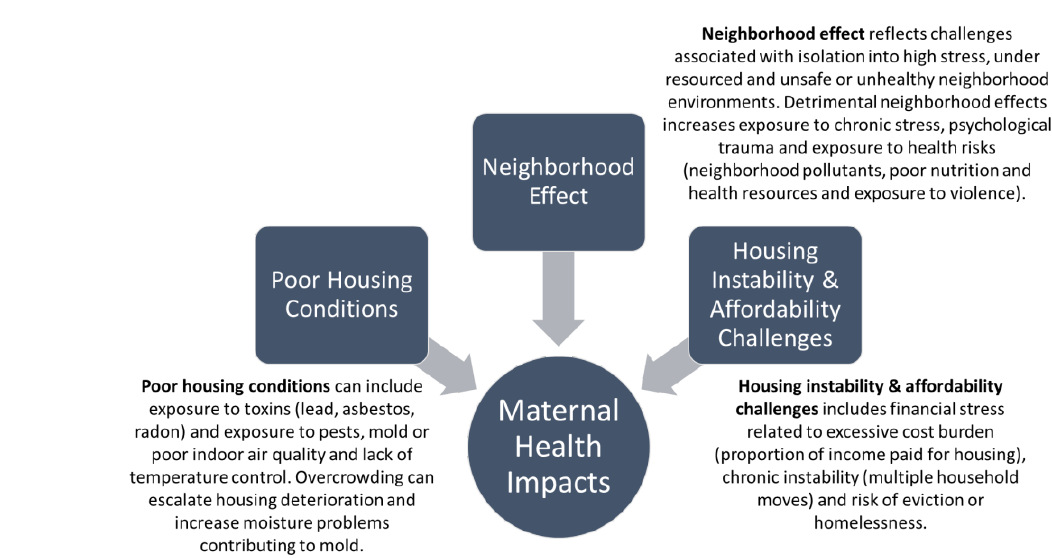
Figure 2. Housing ‘pathways’ that influence infant and maternal health outcomes.